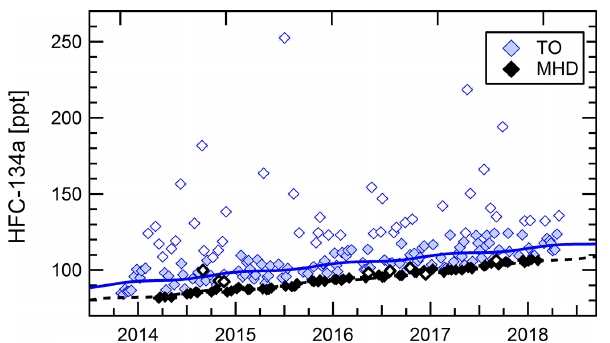
Figure 8. Time series (a) of HFC-134a at Taunus Observatory (blue) and at Mace Head (black). Open symbols in the time series indicate samples flagged as